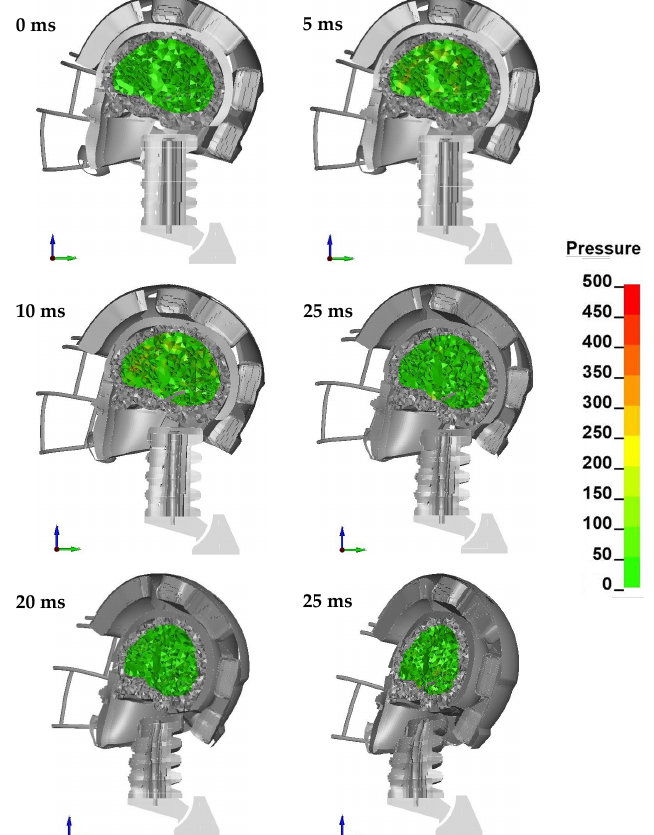
Figure A21. Head kinematics during the numerical test, configuration UT, with the cross-section in the median plane and showing the hydrostatic pressure (kPa) in the cerebrum.